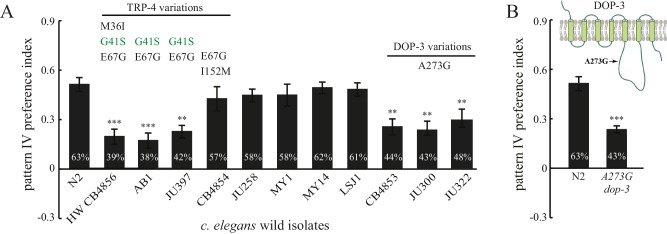
Natural variations in either TRP-4 or DOP-3 tune spatial pattern selectivity in C. elegans.(A) Spatial preference of C. elegans natural isolates was quantified using regular quad-chambers. n = 12 for each strain, ***p<0.001 and **p<0.01 when compared to N2; Dunnett's multiple comparison tests. (B) CRISPR/Cas9 edited N2 worms carrying the A273G substitution and wild type N2 worms were compared using the spatial pattern preference assay. n = 12; ***p<0.001, Student’s t test. Data from the spatial pattern preference assay were collected at 60 min. Error bars denote s.e.m.